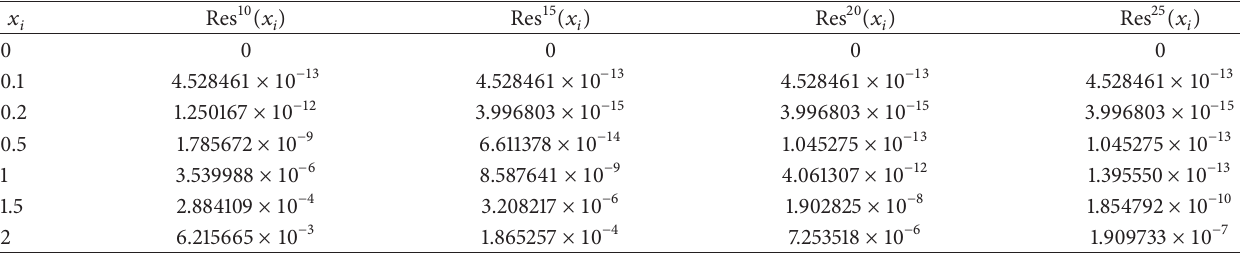
Table 2: The values of the residual error function Res 𝑘 (𝑥) to Example 4 when 𝑘 = 10, 15, 20, 25 for different values of 𝑥 in [0, 2] .